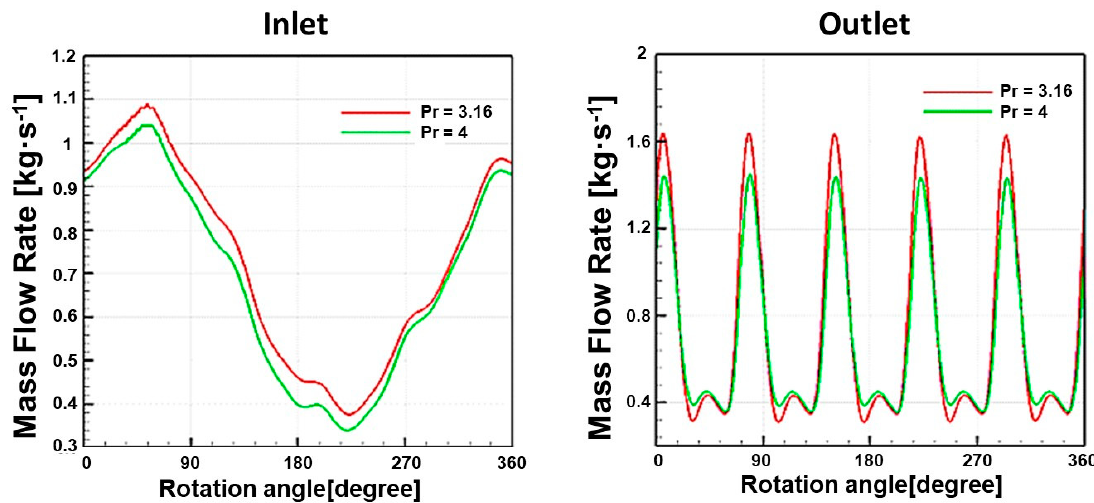
Figure 11. Comparison of mass fl ow rates at di ff erent pressure ratios at inlet and outlet.